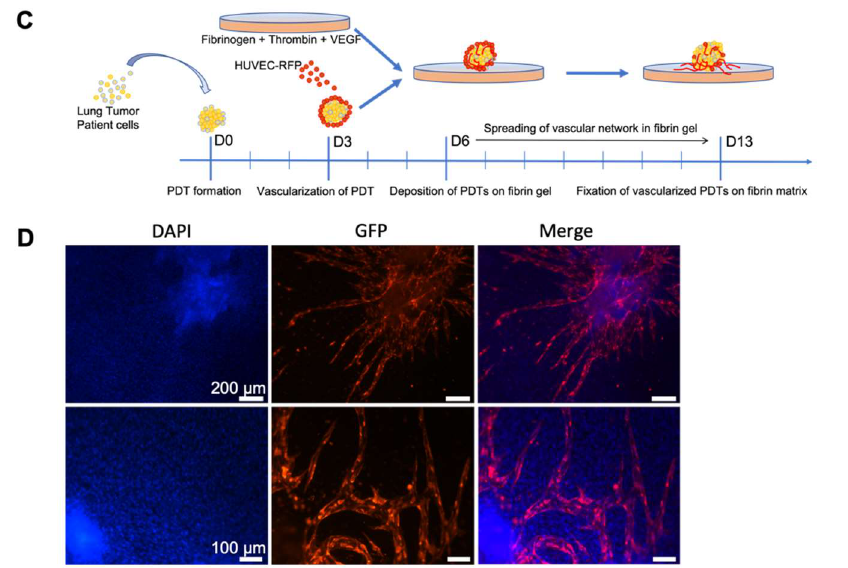
Figure 4. Endothelial cells infiltrate the normal surrounding microenvironment from vascularized PDT. Immunofluorescence analyses for vascularized PDTs. ( A ) cryosection staining; ( B ) whole mount staining. ( C ) Experimental scheme for the combination of vascularized PDT and fibrin gel. ( D ) infiltration of endothelial cells from PDO to fibrin gel.